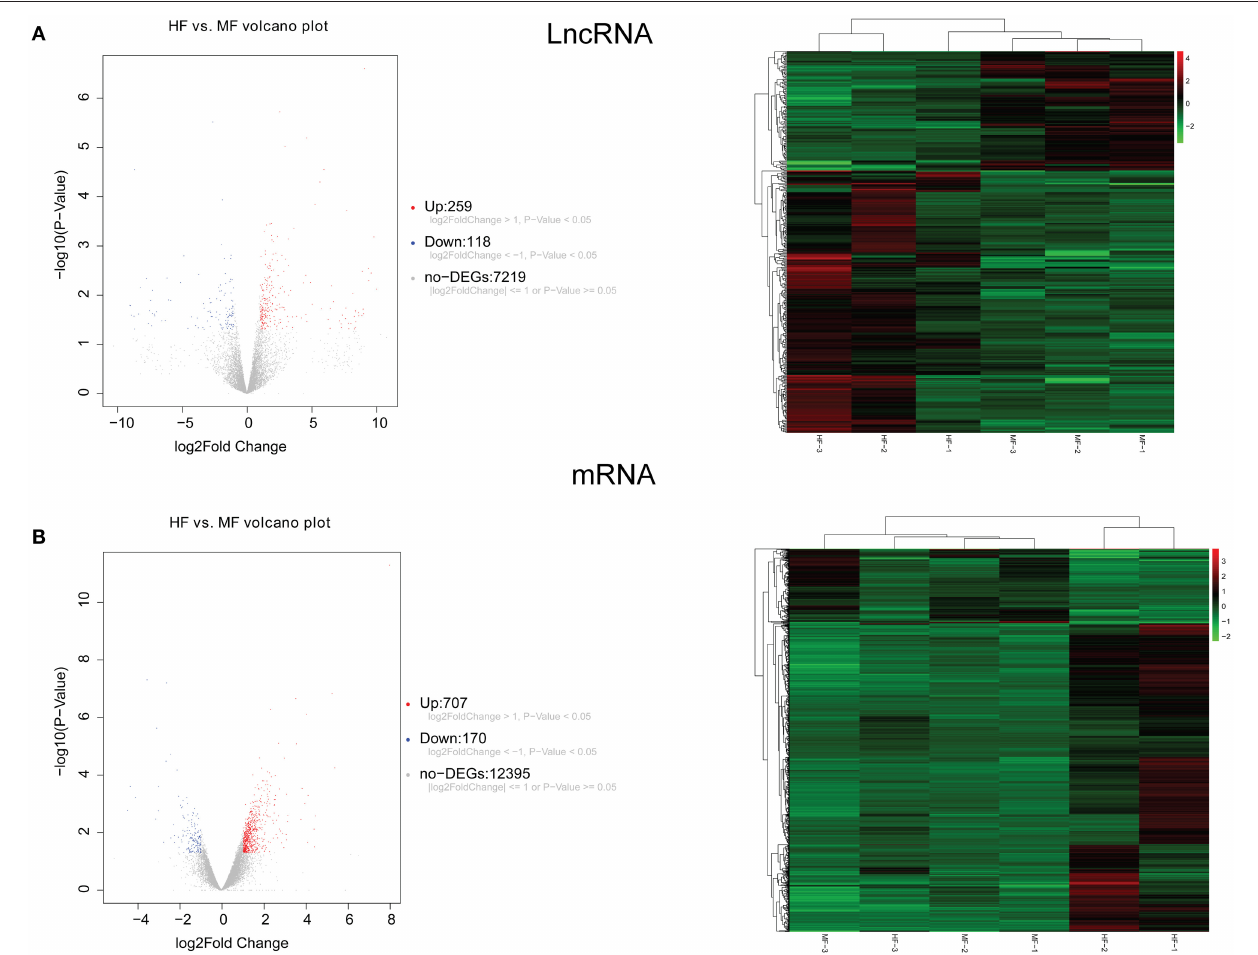
FIGURE 2 | The volcano plot and hierarchical clustering diagram of lncRNAs (A) and mRNAs (B) in HF vs. MF. In the volcano, the x -axis and y -axis present Log2 fold change and –log10 p -value, respectively. Red and blue color represent upregulation and downregulation, respectively. In the hierarchical clustering diagram, the diagram presents the result of a two-way hierarchical clustering of lncRNAs/mRNAs and sample. Each row represents a differentially expressed lncRNA/mRNA, and each column represents a sample. Differentially expressed lncRNAs/mRNAs clustering tree is shown on the top right corner. The color scale illustrates the relative level of differentially expressed genes: red, below the reference channel; green, higher than the